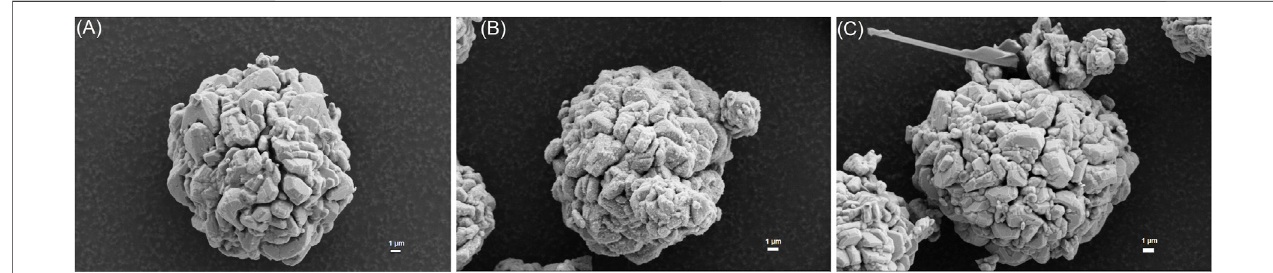
FIGURE 12 | SEM images of (A) pristine, (B) 3 days stored material and (C) 14 days stored material.